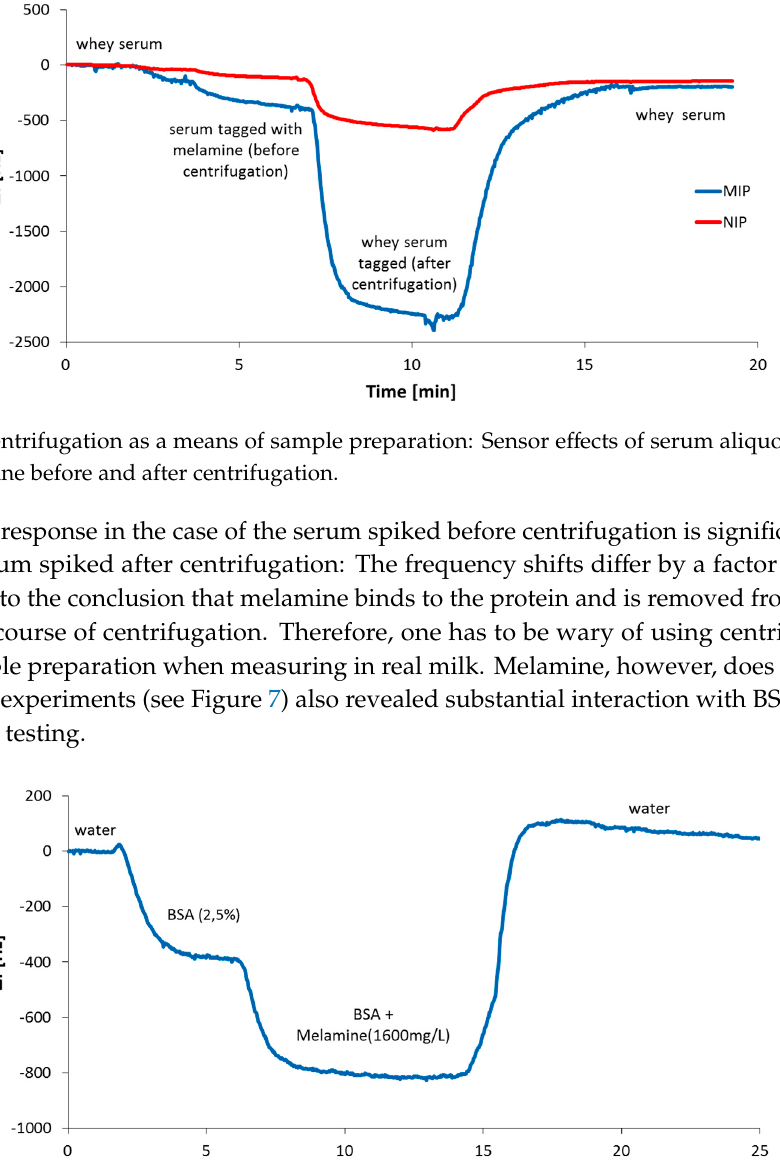
Table 2. Sensor response dependency on protein concentration at a constant melamine concentration level of 1600 mg/L.